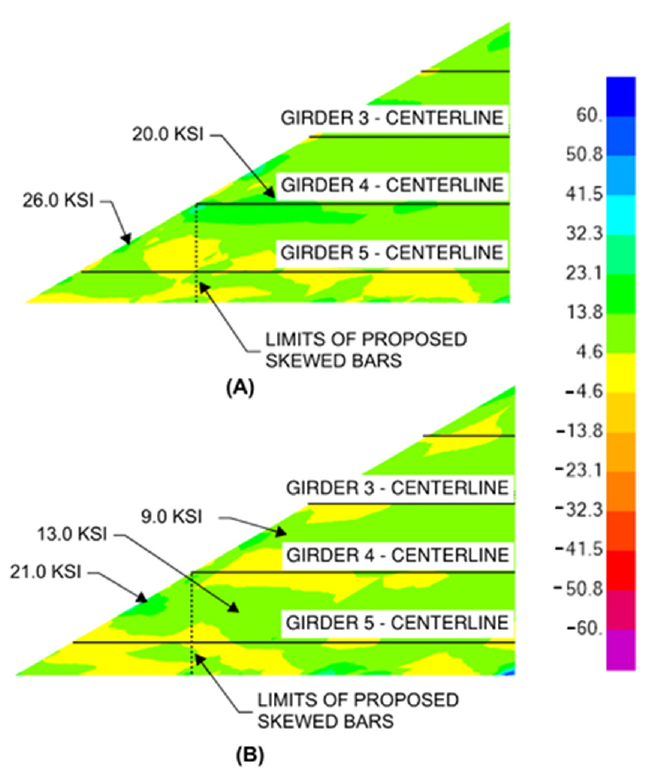
Figure 19. The stress distribution (ksi) in the ( A ) top and ( B ) bottom transverse reinforcement for Service-I limit state, 60 degree model with proposed reinforcement.